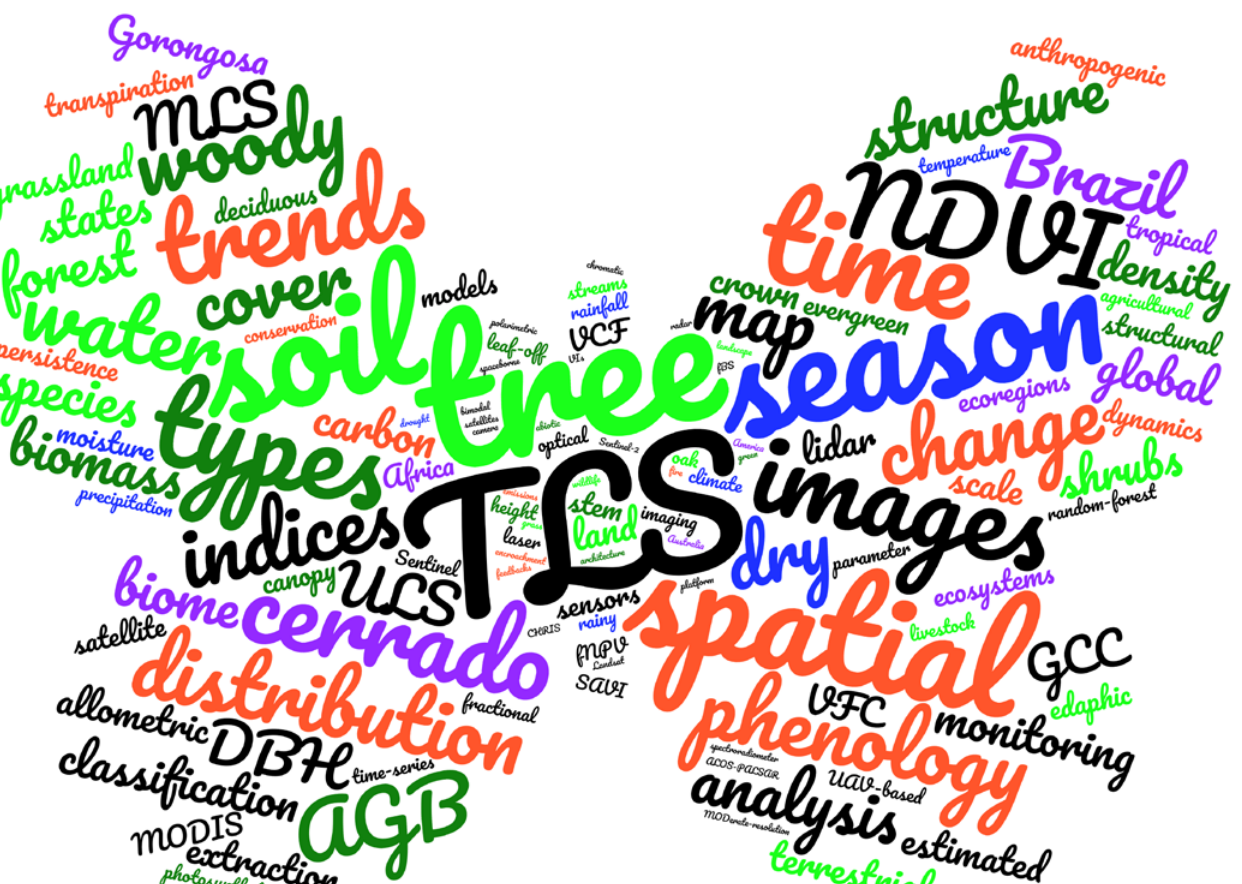
Figure 1. Word cloud based on the article abstracts (two occurrences or more). The terms savanna , woodland , remote and sensing are excluded since they are the topic of the Special Issue. Words represent all versions of the term or concept, e.g., season includes seasonal and seasonality. Only place names and acronyms are capitalized. Color scheme: light green—ecosystem words; blue—climate -related words; red—process words; black—method words; purple—geography words; and dark green—vegetation attribute words. Word cloud produced on http://wordclouds.com (accessed on 6 April 2021).